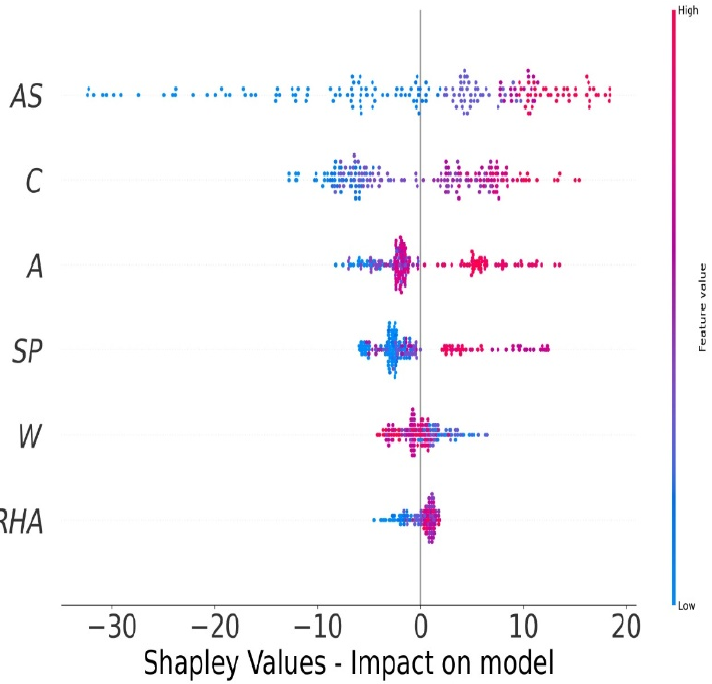
Figure 12. Shapley values of MEP